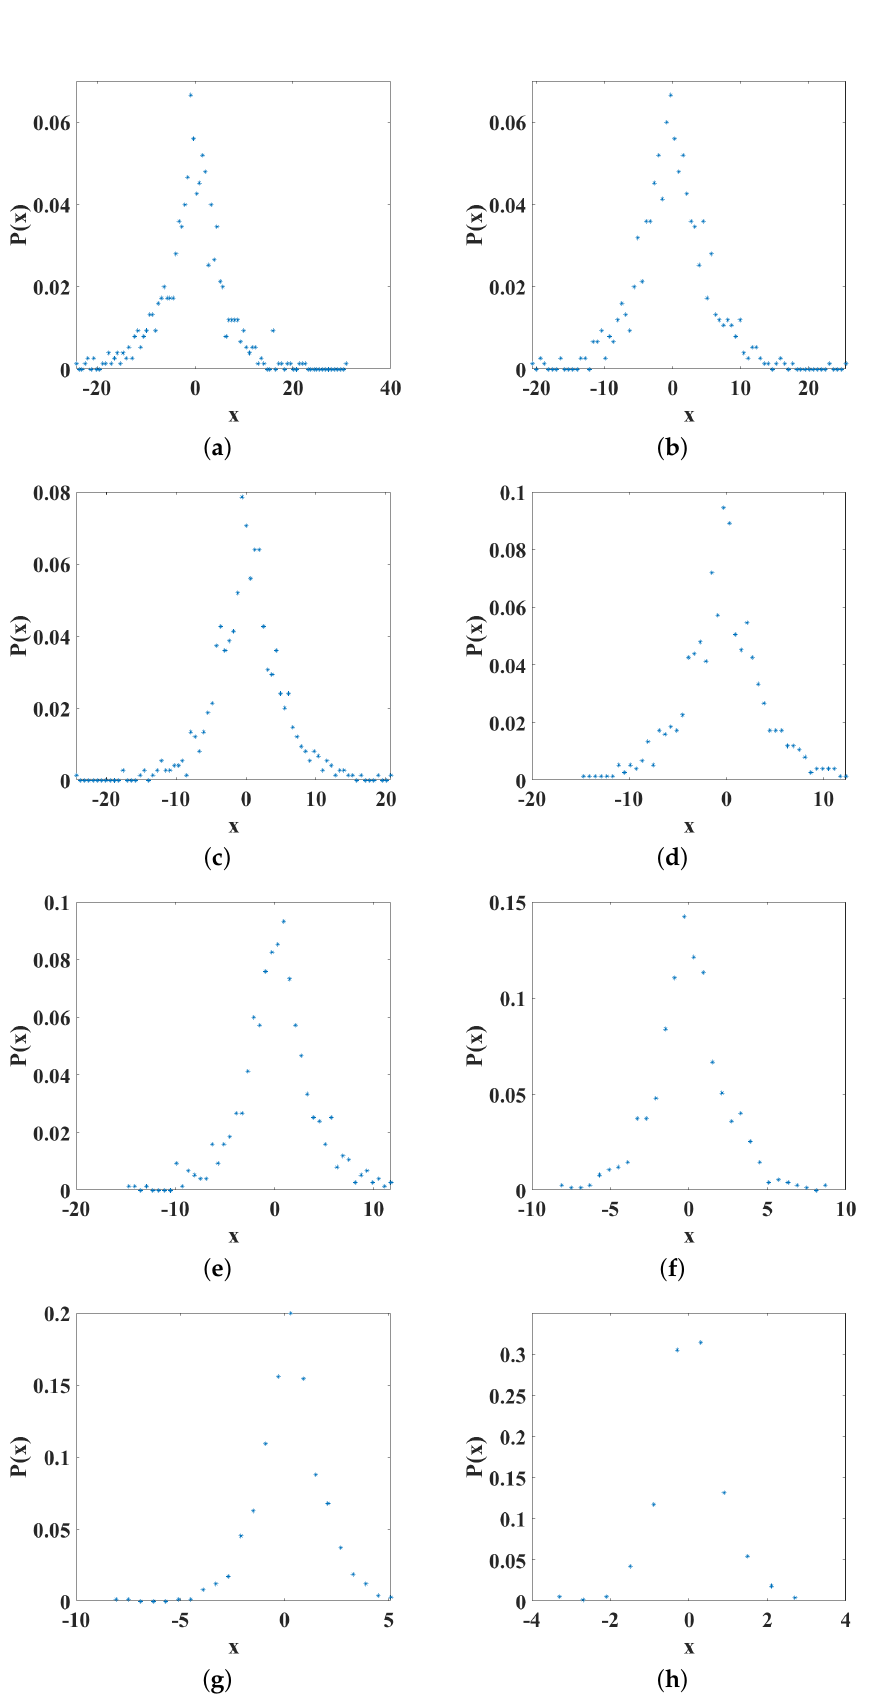
Figure 12. Probability distributions of settling location with changes in k 3 . ( a ) k 3 = 0.60; ( b ) k 3 = 0.68; ( c ) k 3 = 0.76; ( d ) k 3 = 0.84; ( e ) k 3 = 0.92; ( f ) k 3 = 1.00; ( g ) k 3 = 1.08; ( h ) k 3 =